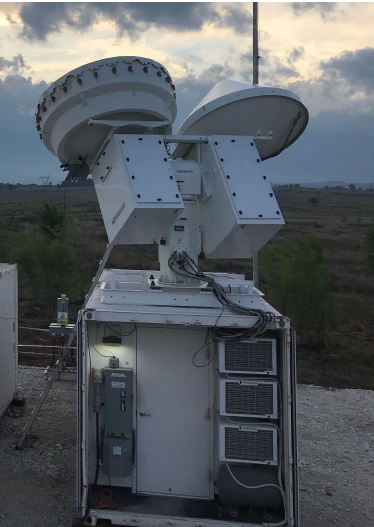
Figure 2. The KaSACR–XSACR deployed at the mobile facility outside of Villa Yacanto, Argentina. The radar is a dual-frequency radar with two antennas mounted on a single pedestal.